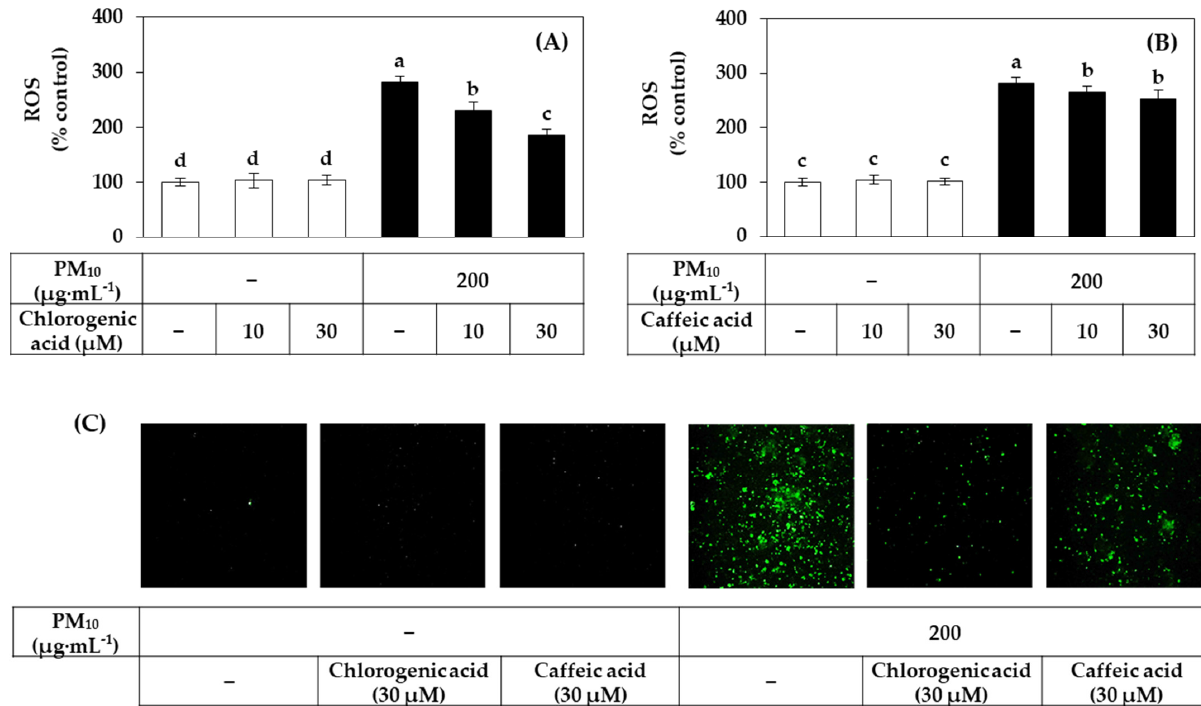
Figure 11. Effects of chlorogenic acid versus caffeic acid on the ROS production in HaCaT keratinocytes exposed to PM 10 . Cells were labeled with DCFH-DA, treated with SHE at different concentrations, and exposed to PM 10 (200 μ g mL − 1 ) for 60 min or not. Typical images of cells fluorescing due to the oxidation of DCFH-DA by ROS are shown in ( C ). The fluo- rescence of the cell extracts was measured to determine ROS levels ( A , B ). Data are presented as mean ± SD ( n = 4). Duncan’s multiple range test was performed to compare all group means to each other. Groups that share the same letters (a–d) do not have significantly different means at the p < 0.05 level.